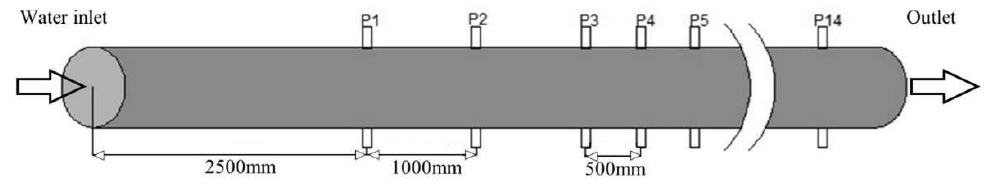
Figure 4. Scheme on the distribution of the sampling soft rubber pipes.